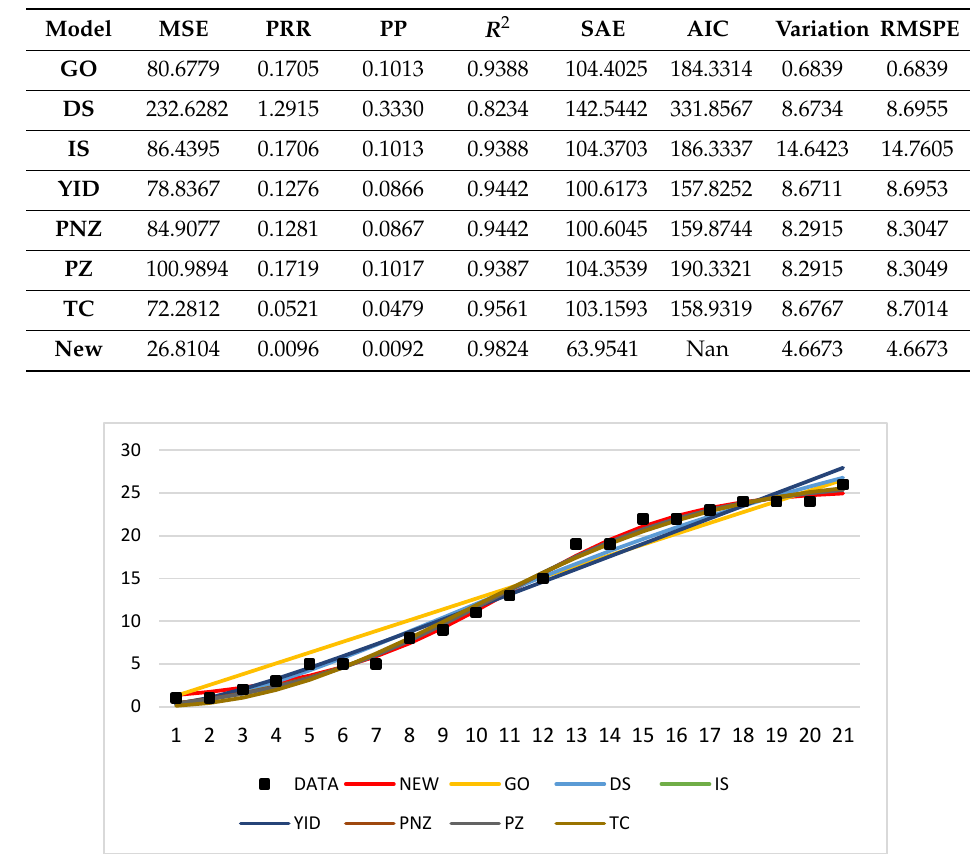
Table 5. Comparison of all criteria for dataset 2.